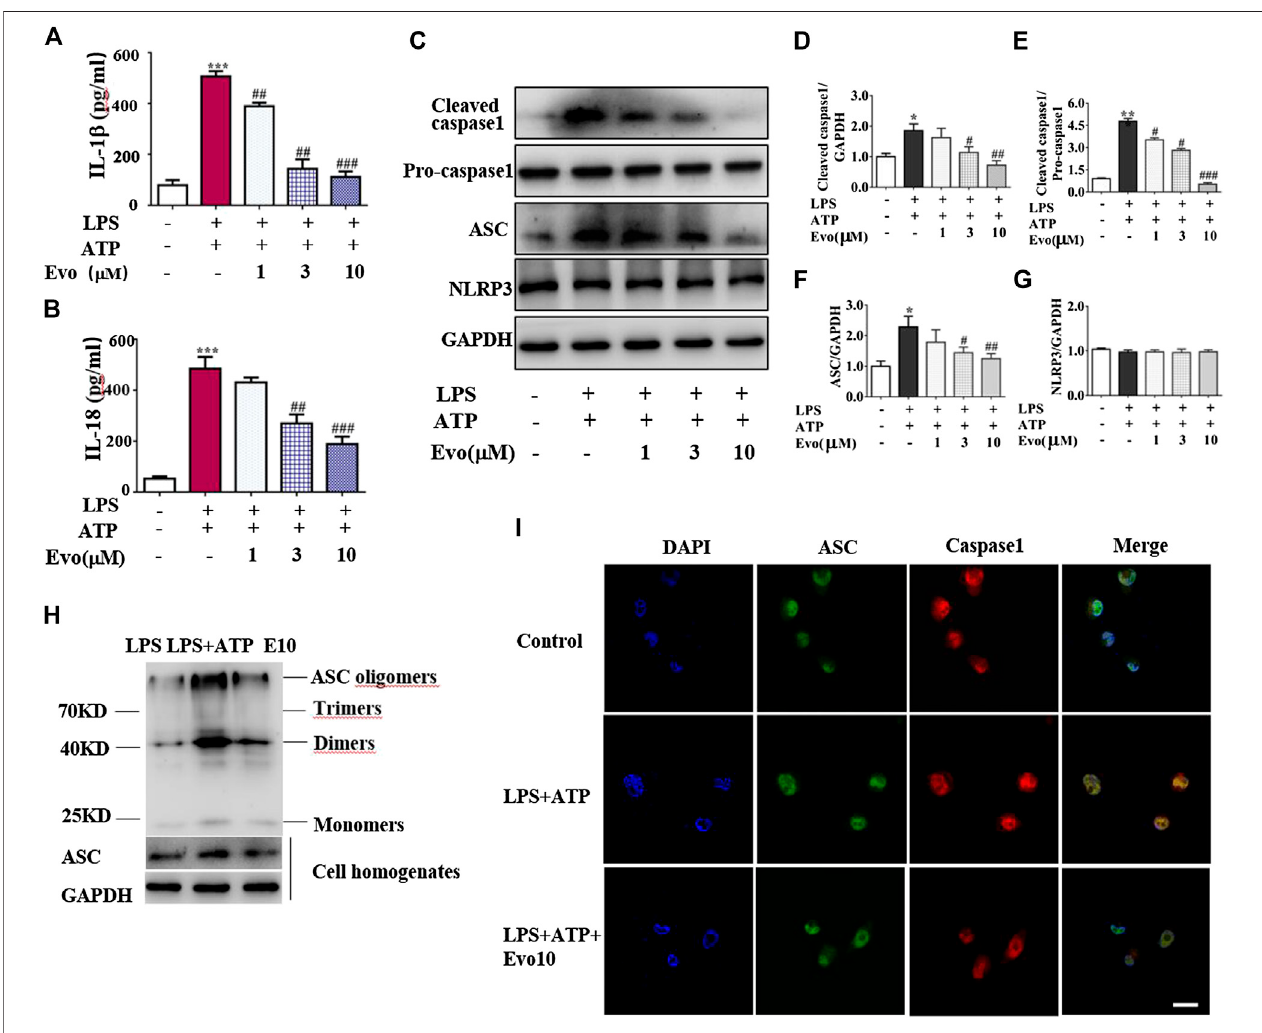
FIGURE 4 | Evodiamine attenuated NLRP3 in fl ammasome activity in THP1 macrophages via inhibition of ASC oligomerization. Cells were stimulated with LPS (100 ng/ml) for 3 h and evodiamine for 1 h, then incubated with 5 mM ATP for 1 h. (A,B) Levels of IL-1 β and IL-18 in THP1 cells were determined by ELISA. (C) Expressions of cleaved caspase1, pro-caspase1, ASC and NLRP3 in THP1 cells were determined by immunoblot. (D – G) Quanti fi cation of Figure 3C . (H) ASC oligomerization in THP1 cells were analyzed by immunoblot. (I) Immuno fl uorescence microscopy of THP1 stained with anti-ASC (green) and anti-caspase1 (red) antibodies.DAPIstainingidenti fi ednuclei.Scalebar,20 μ m.Theresultsarerepresentative ofatleastthreeindependentexperimentsandexpressed asmean ± SD.* p < 0.05, ** p < 0.05, and *** p < 0.001 compared with the control, # p < 0.05, ## p < 0.01, and ### p < 0.001 compared with the LPS + ATP group.